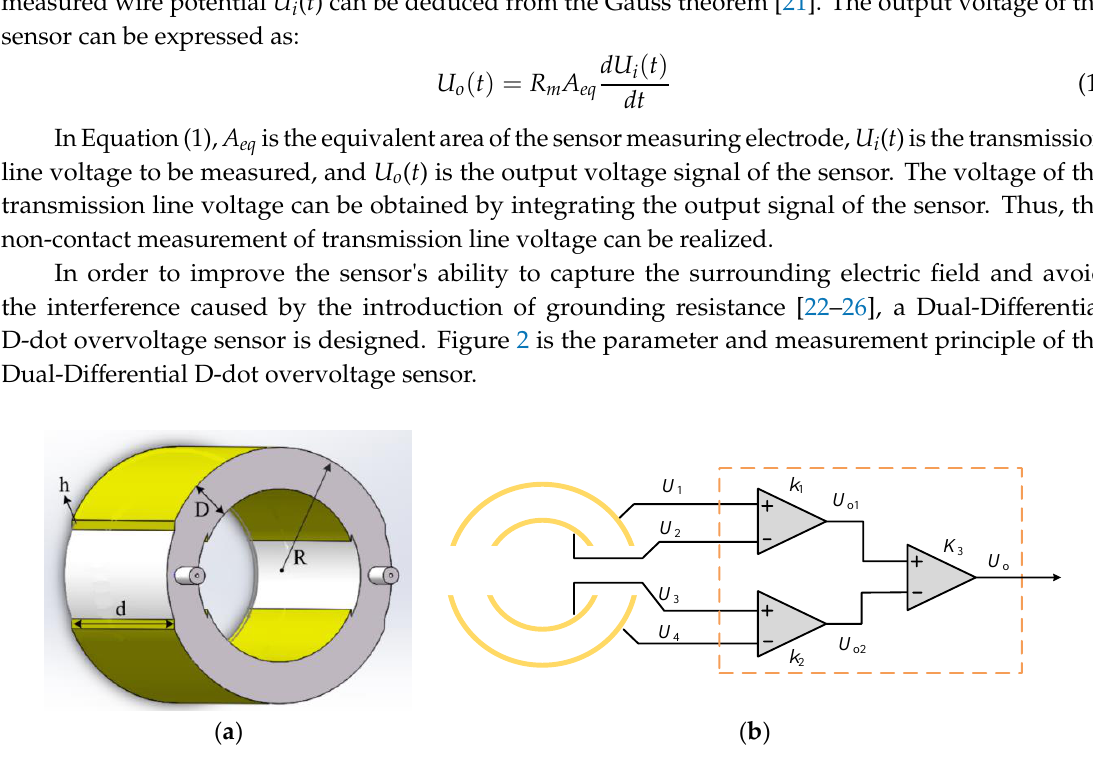
Figure 2. Parameter structure and measurement principle of the Dual-Differential D-dot overvoltage sensor: ( a ) The structural parameter of the Dual-Differential sensor; ( b ) the signal measurement principle of the sensor.